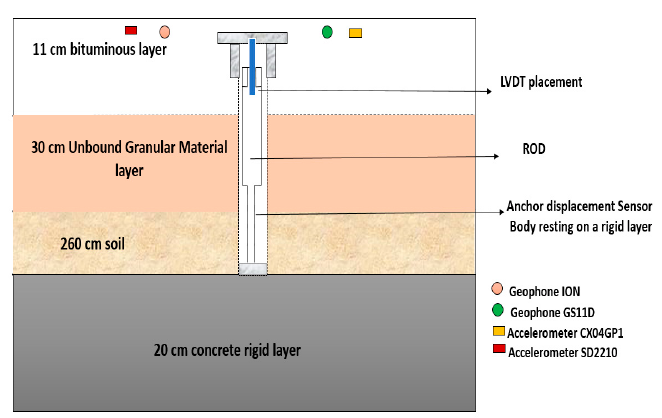
Figure 13. APT section dimensions